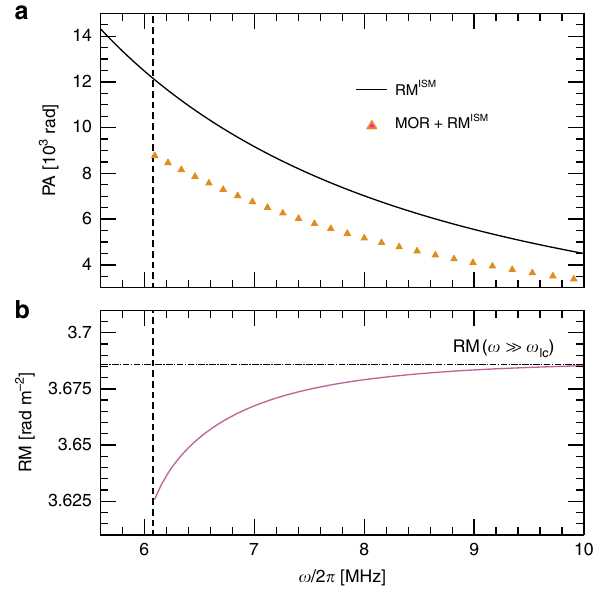
Fig. 2 Mechanical polarisation rotation in a rotating symmetrical e – p plasma. Panel ( a ) illustrates the mechanical-optical rotation (MOR) per unit length δ M = Δ ϕ M / l (in solid blue) as a function of the normalised wave angular frequency ω / ω c , and panel ( b ) highlights the behaviour near the cut-off. Well above the cut-off ω lc MOR scales like ω − 2 (in dashed teal), similarly to Faraday rotation. In a limited frequency band above ω ð½ ω = ω (cid:5) 1 (cid:6) (cid:7) 1 Þ highlighted in panel ( b ), a different scaling is found (in lc lc dotted orange), making it in principle possible to separate mechanical effect from Faraday rotation. B 0 = 10 8 T, n = 7 × 10 20 m − 3 and P = 0.5 s,